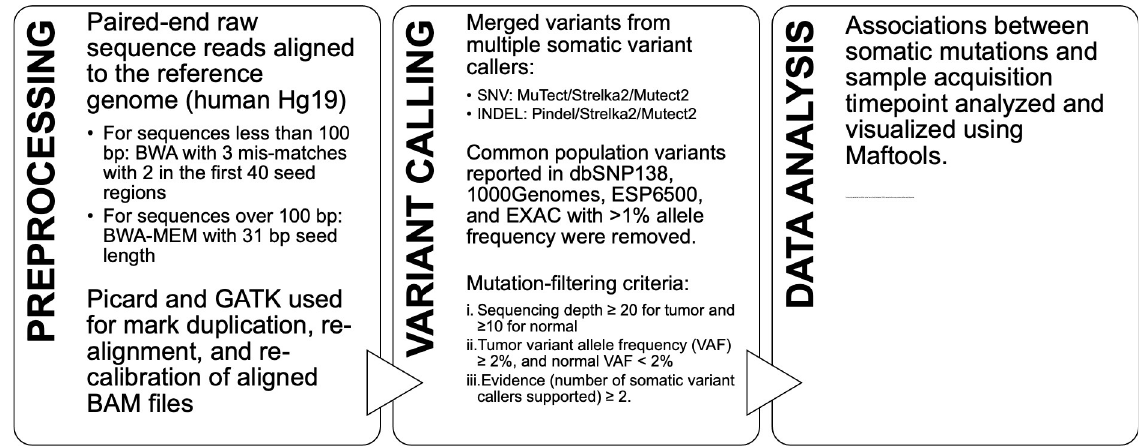
Fig 2. Computational pipeline for whole exome sequencing data. Workflow depicting preprocessing, variant calling and data analysis tools and parameters implemented to analyze WES data acquired from tumor DNA collected by cervical swab.